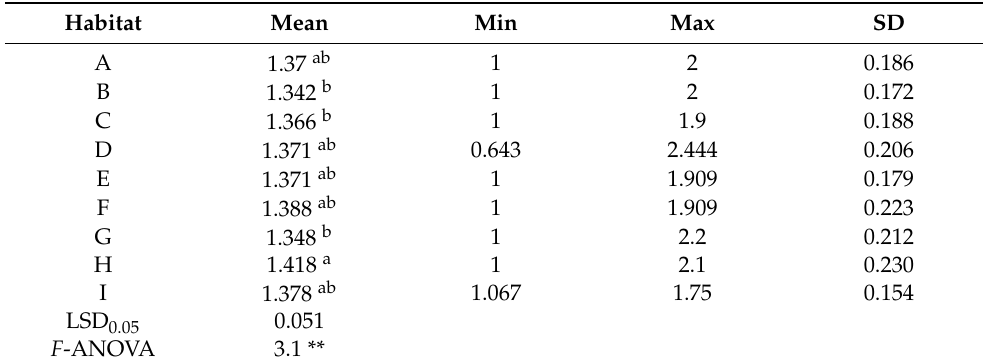
Table 6. Mean values, minimal, maximal and standard deviations (SD) as well as homogenous groups of the ratio of the length of the longest polar axis and length of the shortest polar axis (LA/SA), A–I abbreviated habitat names (see: Table 1).